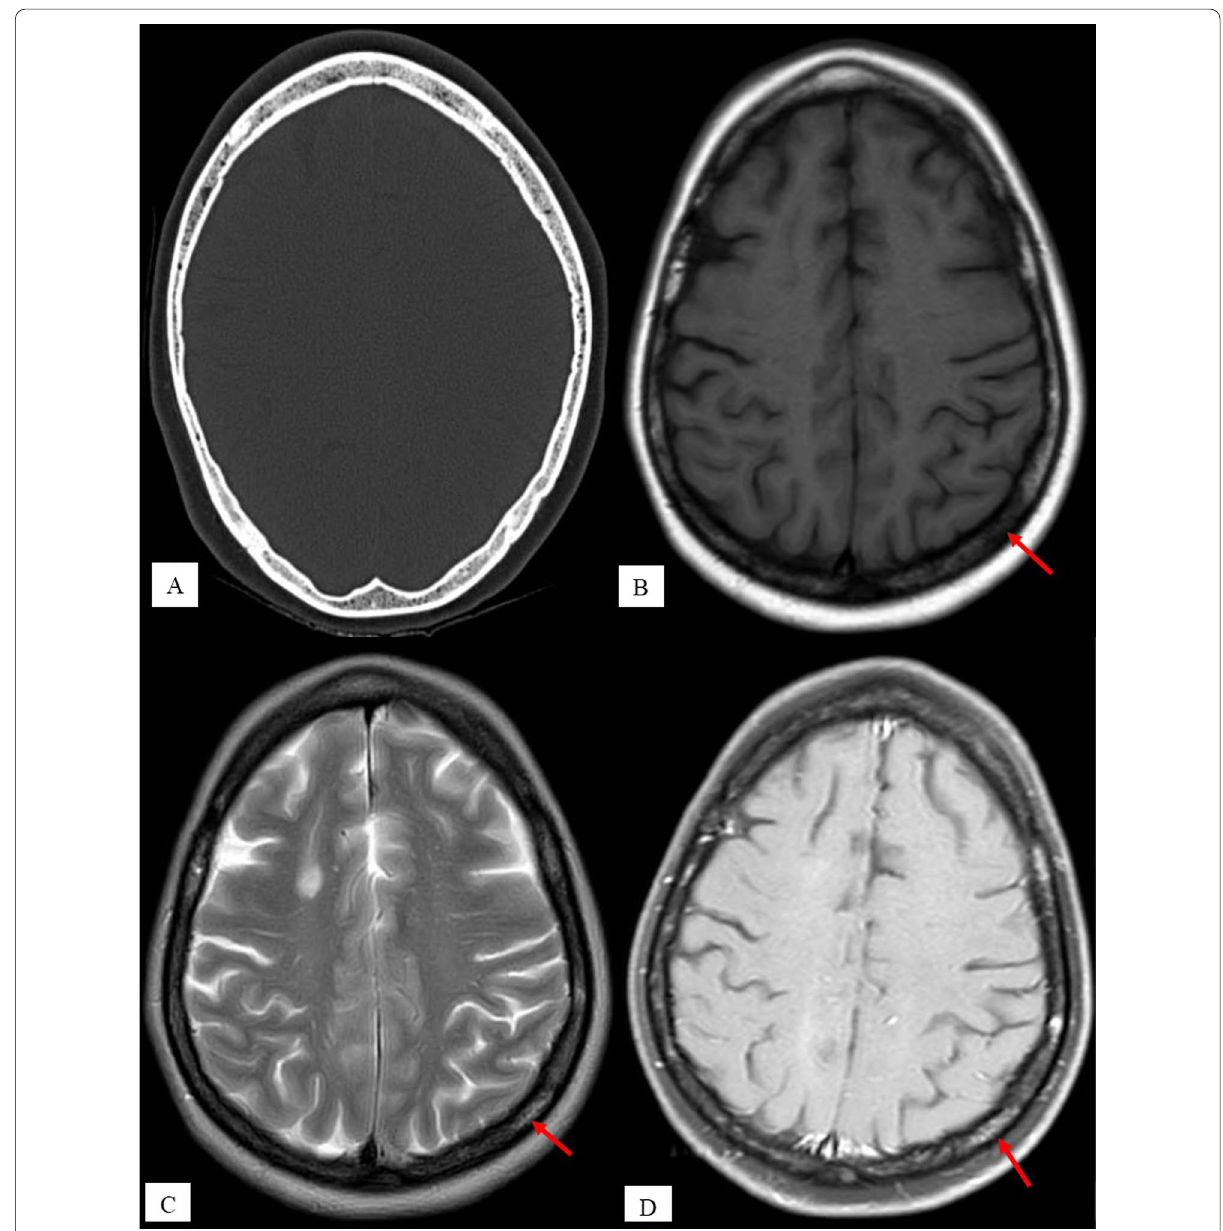
Fig. 6 Detection of lesions confined to bone marrow by MRI in a 38 year old female known case of leukemia- CT bone window image ( A ) shows no abnormality. MR images demonstrate altered marrow signal intensity with few areas appearing hypointense on T1W ( B ) and hyperintense on T2W ( C ) images, showing enhancement on post contrast T1W images ( D ). These lesions represent leukemic infiltrates which were not picked up by